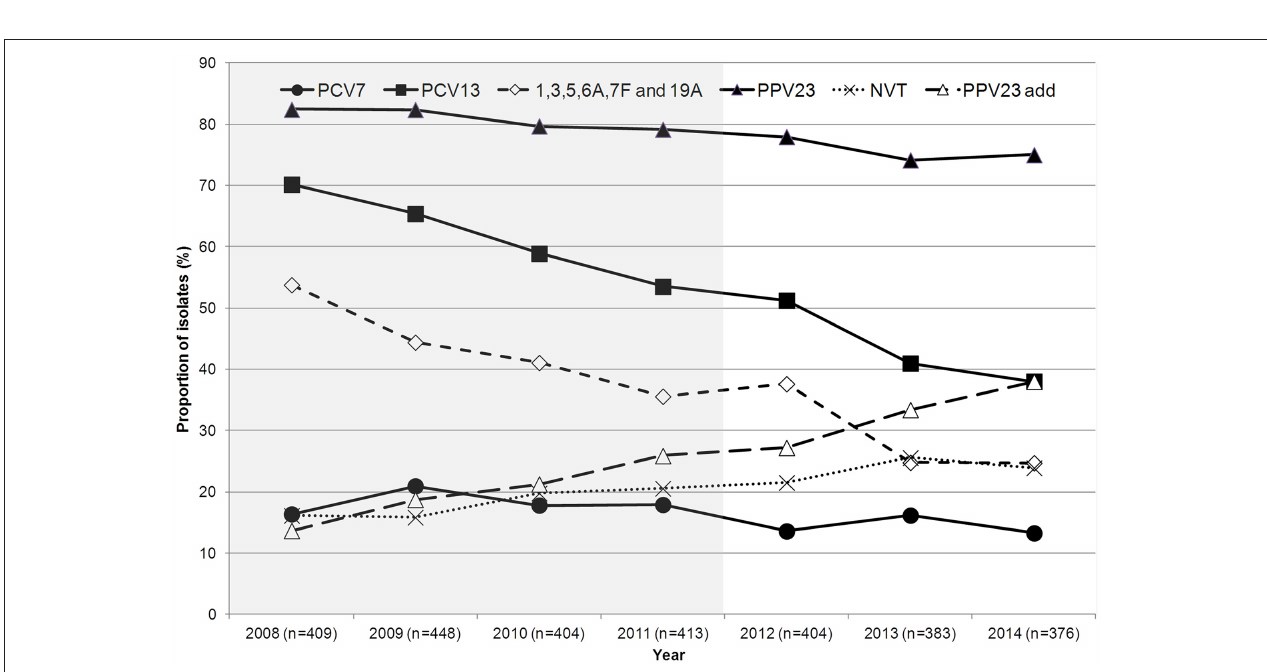
FIGURE 4 | Proportion of isolates expressing serotypes included in pneumococcal vaccines causing invasive pneumococcal disease in adult patients ( ≥ 18 years) in Portugal, 2008–2014. The data up to 2011 were presented previously (Horácio et al., 2012, 2013).